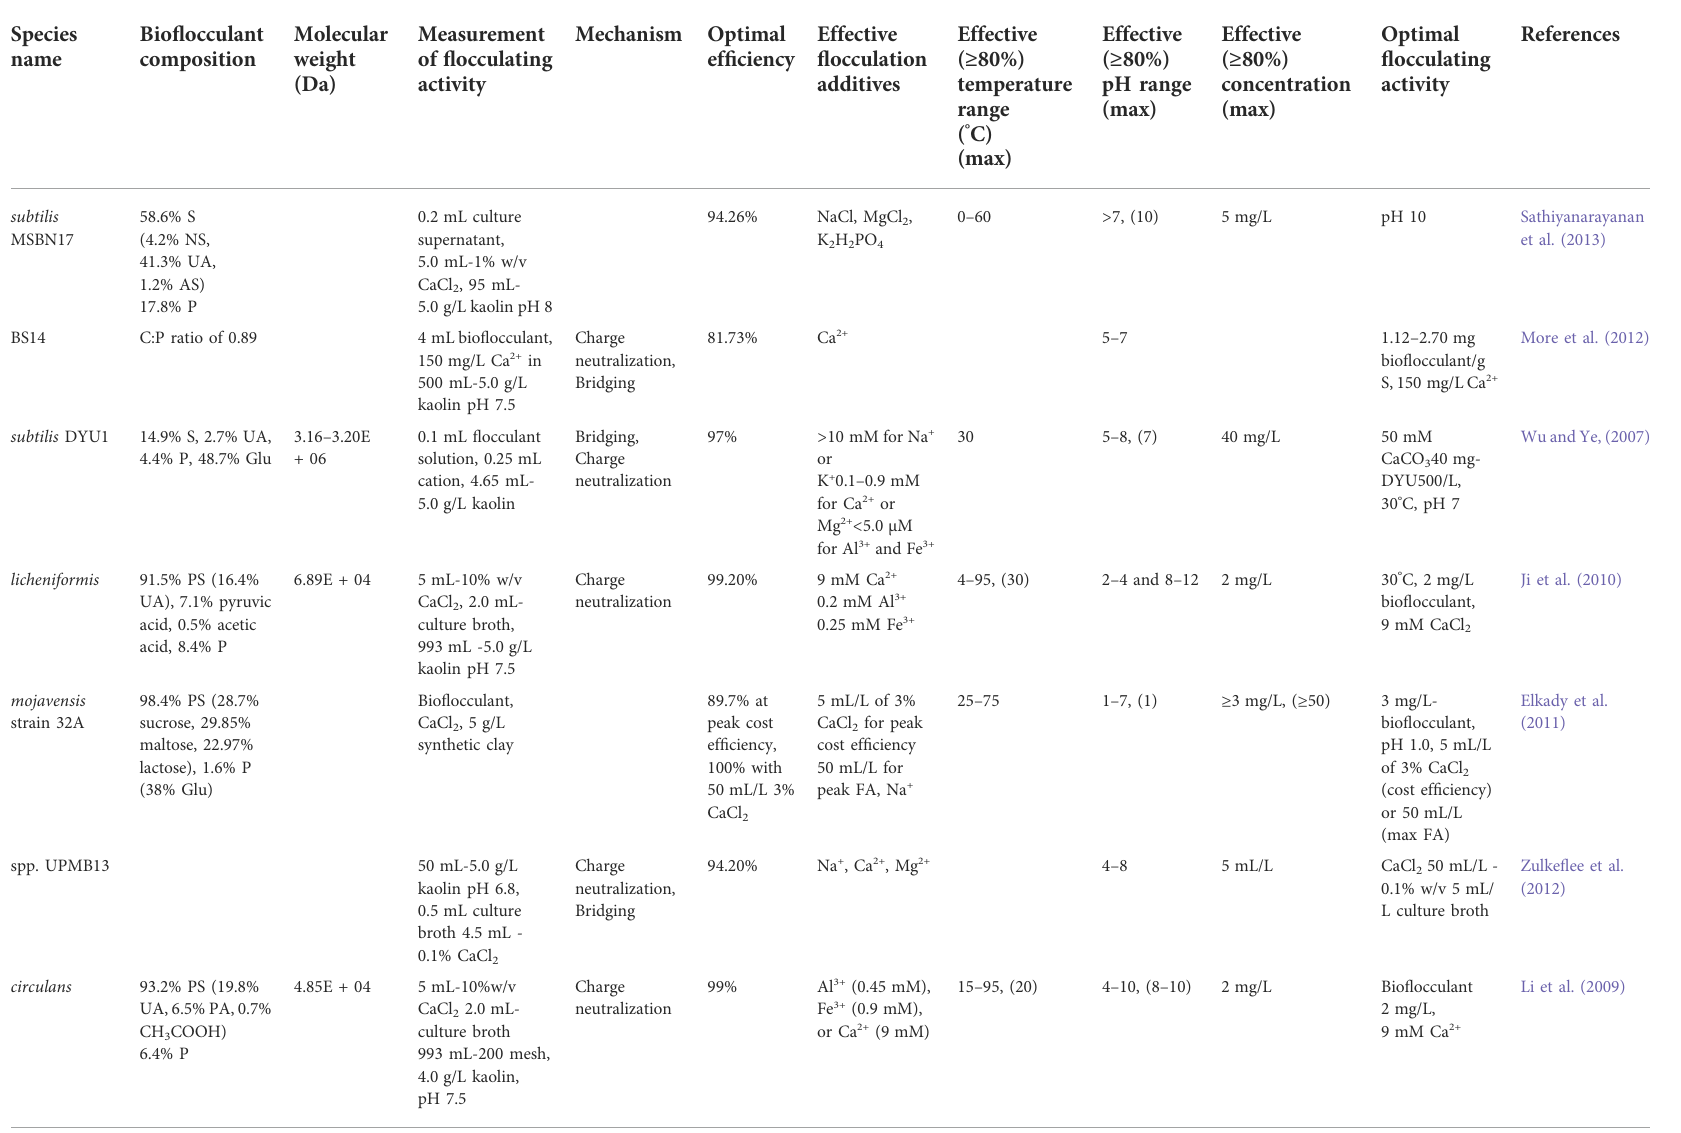
TABLE 1 Bacillus genera and their bio fl occulant